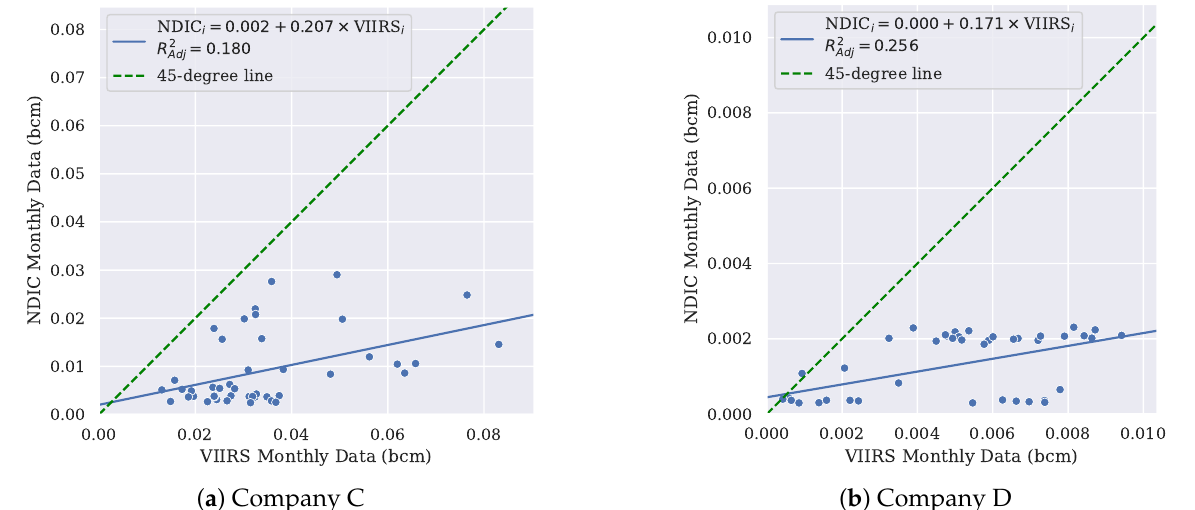
Figure 24. Examples of poor fits between the NDIC and VIIRS reported volumes, at the company level.